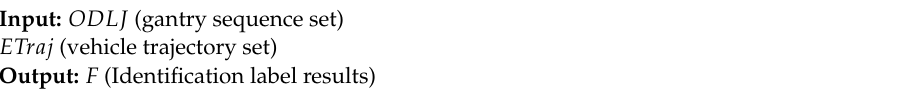
Algorithm 2. Feature recognition algorithm for abnormal transaction data